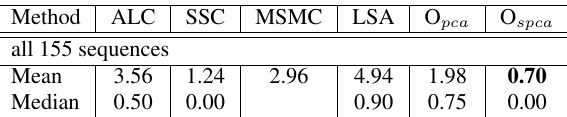
Table 2: Mean and median of the misclassification (%) on the Hopkins 155 dataset with 3 motions.